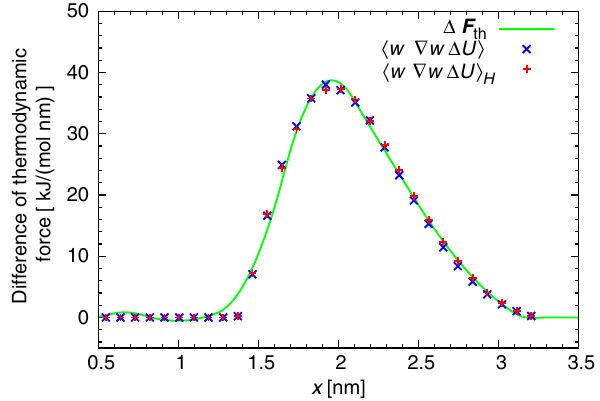
FIG. 10. The difference between the thermodynamic force of the potential interpolation-based scheme and the force interpo- lation of the standard AdResS. The green solid line shows the difference of the thermodynamic forces, i.e., (cid:1) F th ¼ F H th (cid:1) F th . The blue and red symbols indicate the quantity h w r w ð U AT (cid:1) U CG Þi calculated in the two different approaches. (Blue corre- sponds to the standard AdResS, while red corresponds to the Hamiltonian-based approach.) The equivalence between the two approaches is suggested by the fact that (cid:1) F th corresponds to h w r w ð U AT (cid:1) U CG Þi and that such a term is actually the same, independently from the approach used to calculate